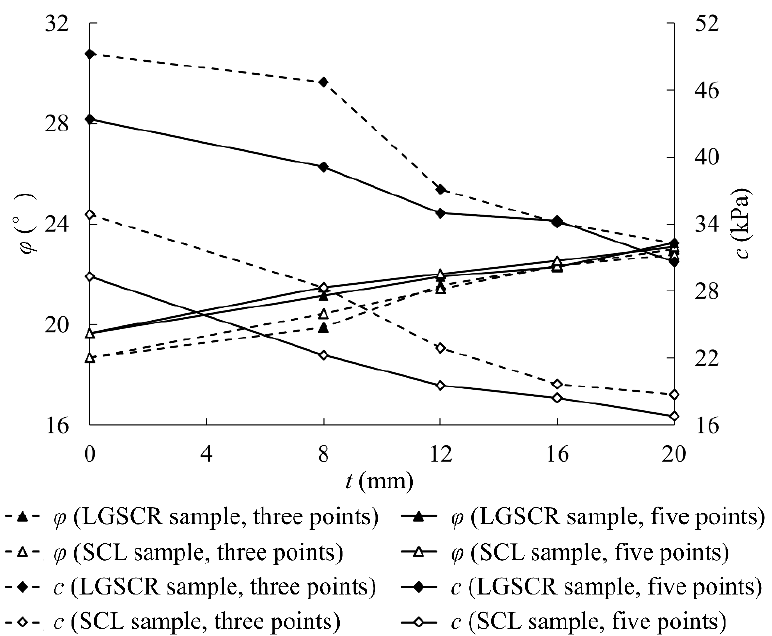
Figure 13. The peak stress–confining pressure curves of the samples at different thicknesses of sand layers.